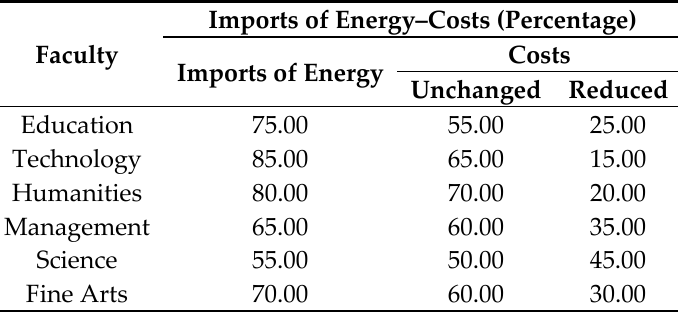
Table 2. Imports of Oil, Electricity, LPG and